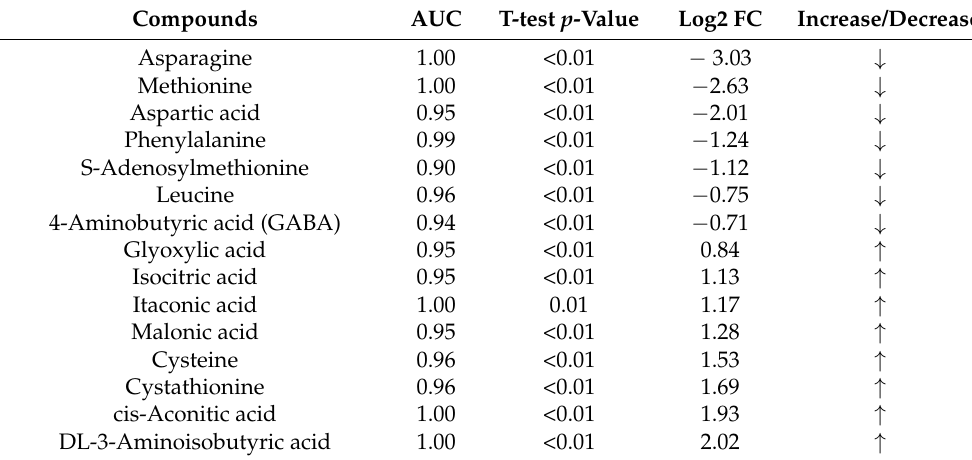
Table 3. Haemolymph metabolites with AUC greater than 0.9, identifying them as putative biomark- ers for transport stress. The decrease or increase shows the change of metabolites in post-transported abalone relative to the control